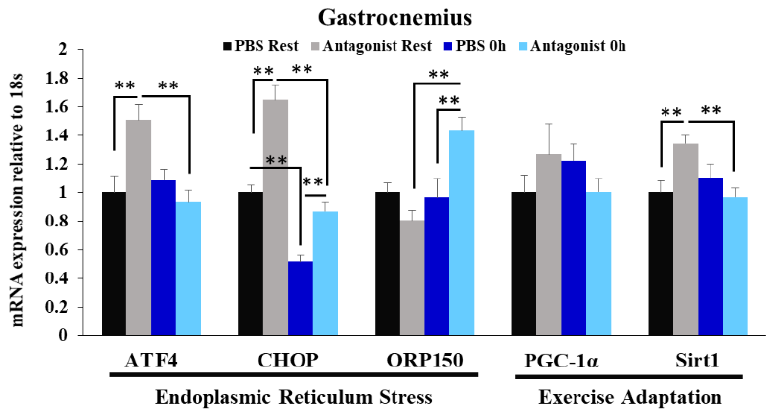
Figure 4. Gene expression of endoplasmic reticulum stress marker and inducing exercise adaptation ( n = 6). Data are shown as mean ± SE. Data were analyzed using two-way ANOVA followed by Bonferroni post hoc test (** p < 0.01). ATF4, activating transcription factor 4; CHOP, C/EBP homologous protein; ORP150, oxygen-regulated protein 150; PGC- 1α, peroxisome proliferator -activated receptor coactivator- 1α; Sirt1, sirtuin 1; ANOVA, analysis of variance; SE, standard error.